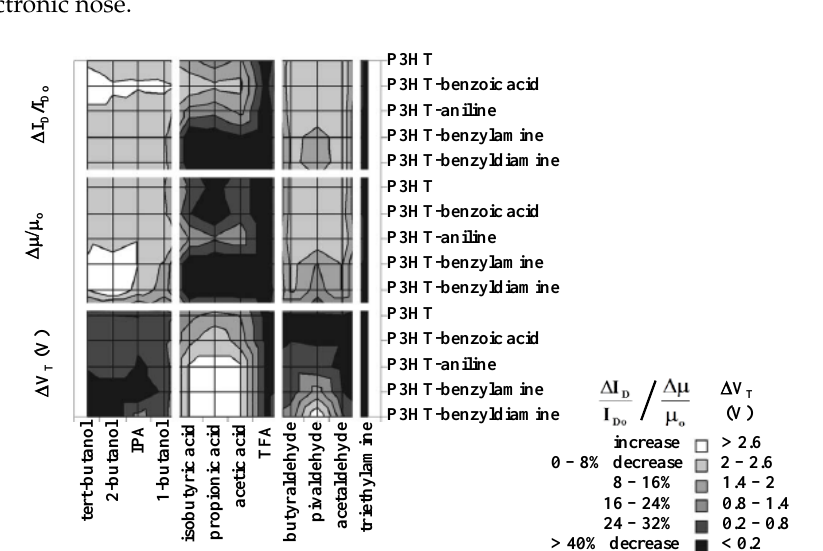
Figure 6. Response of five polymers toward twelve gas analytes in the sensor array. Baseline is established through operation in ambient conditions, and sensor response is measured after exposure to 40 ppm of each analyte for 2 min. Reprinted with permission from Ref. [39]. Copyright (2006) American Institute of Physics.